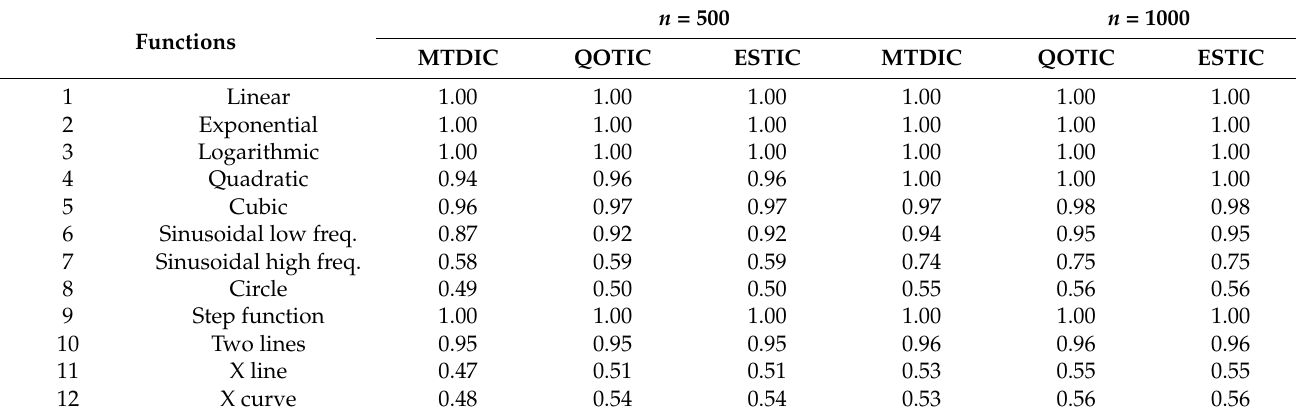
Table 3. Generality performance of MTDIC, QOTIC, and ESTIC .